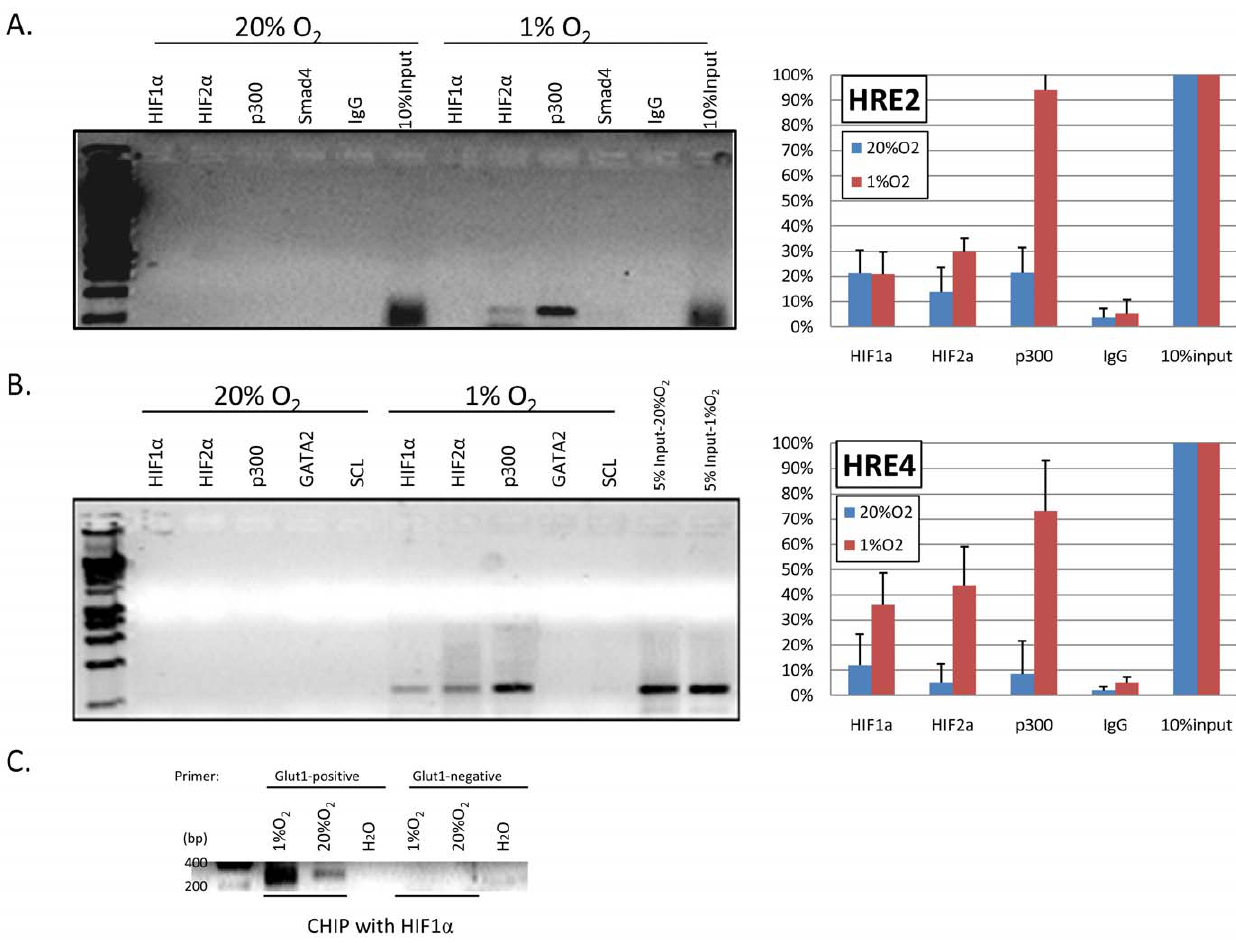
Figure 4. HIF and co-activator p300 are associated with BMP4 under hypoxia in MSS31 cells. The binding of Hif1 a , Hif2 a , and p300 to these sites was investigated by ChIP assay in MSS31 cells cultured at 20% O 2 or 1% O 2 for 16 hours. IgG or other antibodies served as controls. PCR were performed with primers amplify HRE-2 (A) and HRE-4(B). Representative gel data are shown. The relative intensity of PCR products normalized to the input lanes is shown by combining data from three to five individual ChIP assays. (C) Positive and specificity controls of ChIP with Hif1 a were examined at Glut-1 locus.